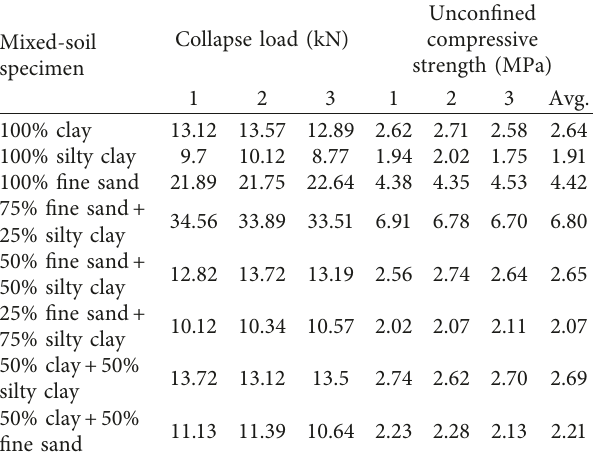
Table 7: Unconfined compressive strength of mixed-soil